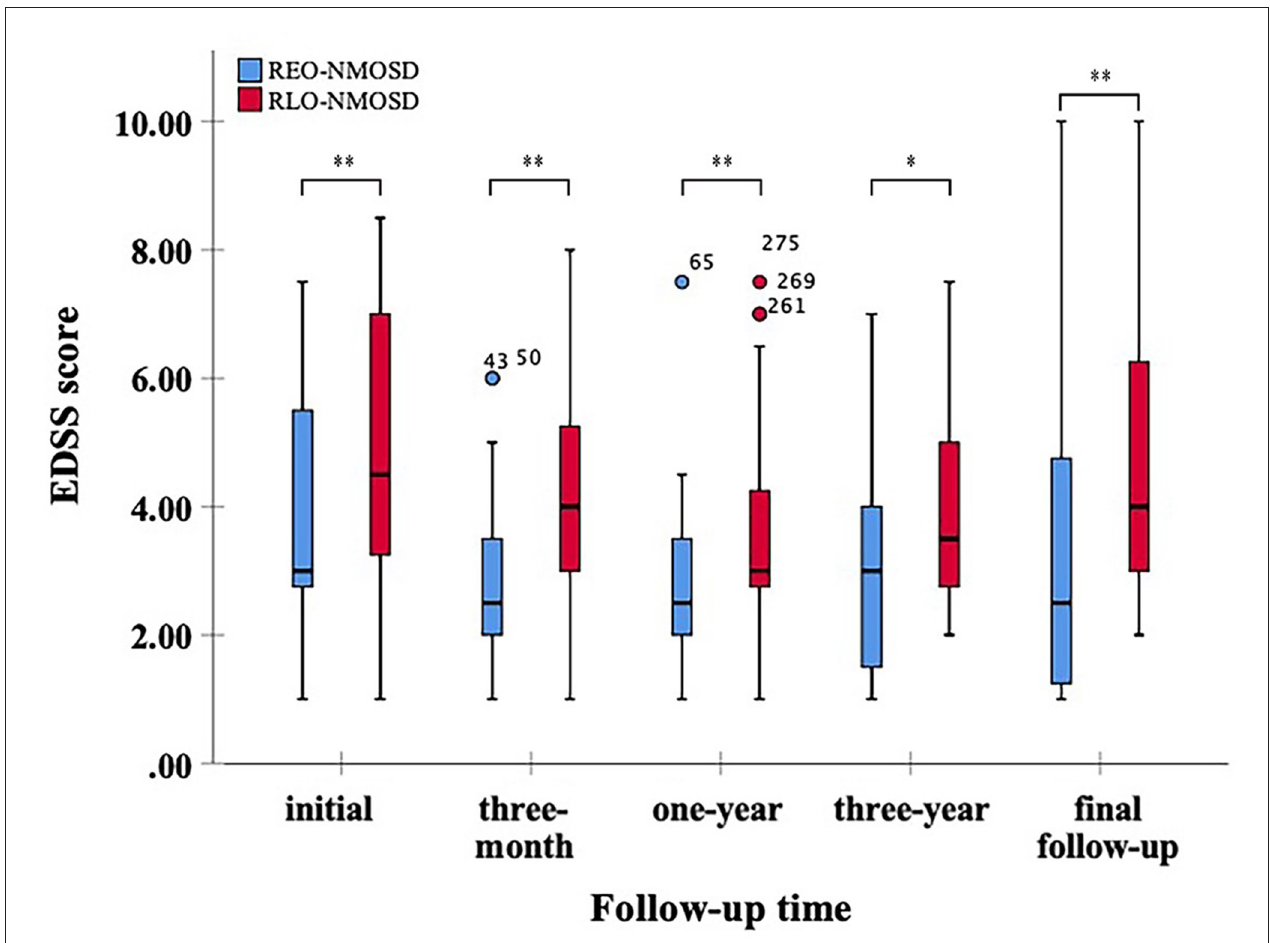
FIGURE 1 | Expanded disability status scale (EDSS) scores at different time periods between patients with relatively early-onset neuromyelitis optica spectrum disorder (REO-NMOSD) and relatively late-onset neuromyelitis optica spectrum disorder (RLO-NMOSD) patients. (* p <0.05,** p